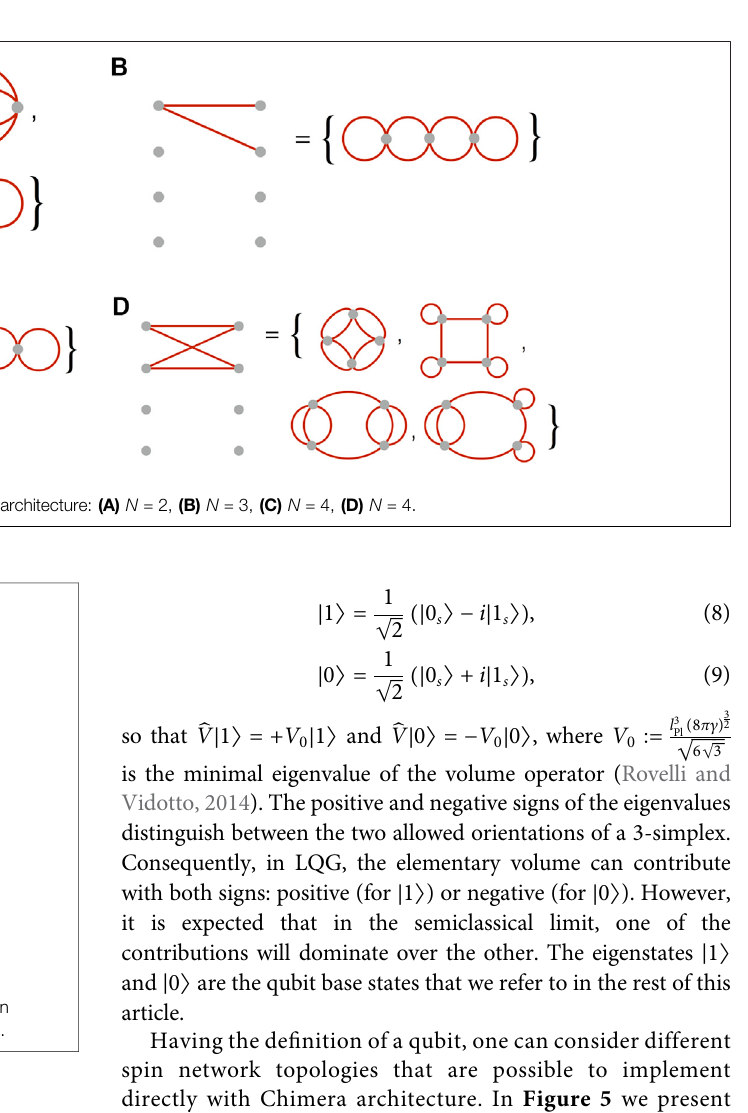
Frontiers in Astronomy and Space Sciences |